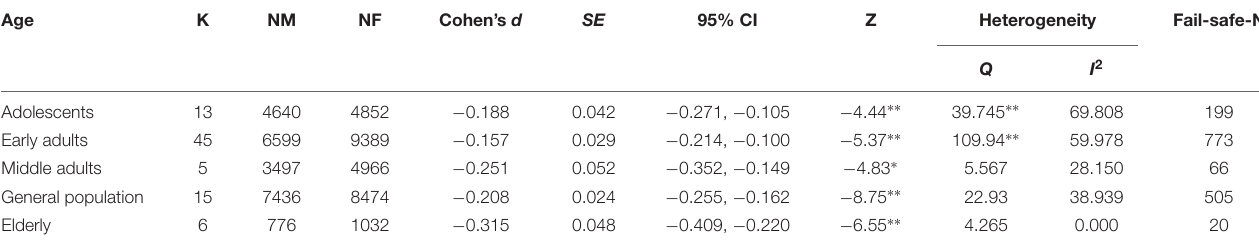
TABLE 1 | Effect sizes of gender difference in BDI (Beck Depression Inventory) total score across age groups.